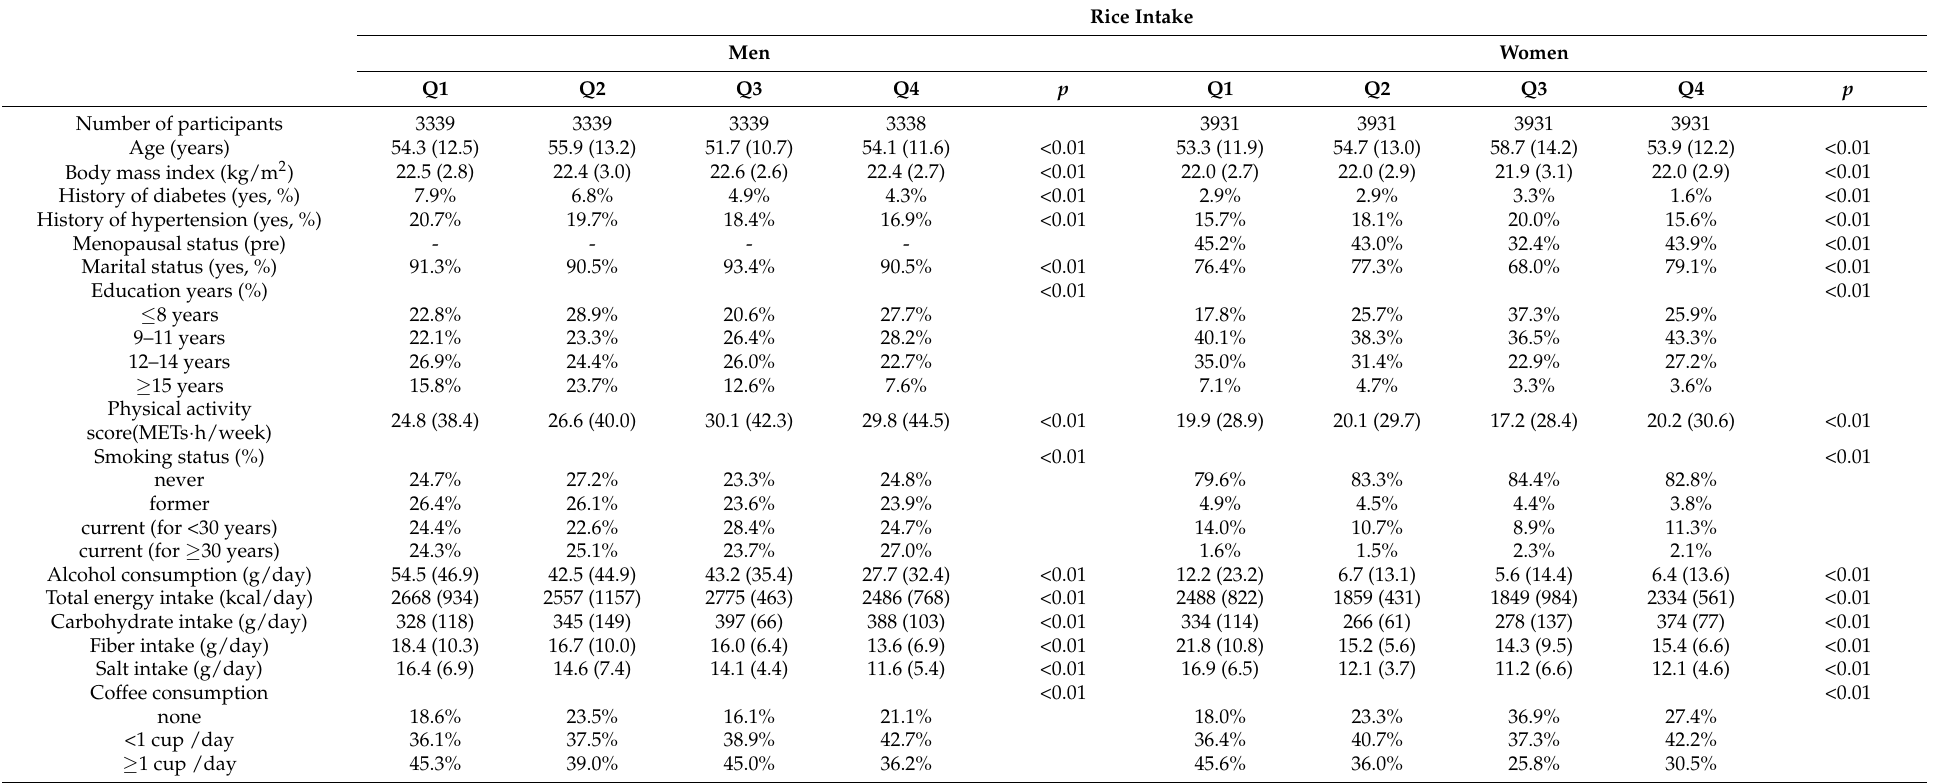
Table 1. Characteristics of study participants at baseline according to the quartiles (Q1–Q4) of intake of rice as a grain